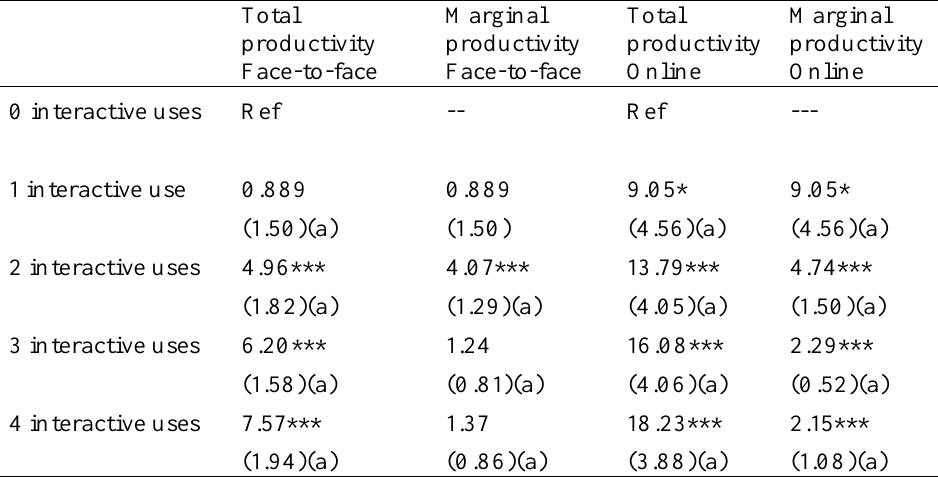
Total and Marginal Productivity of Interactive Uses of the Internet in Education, by Study Mode Total